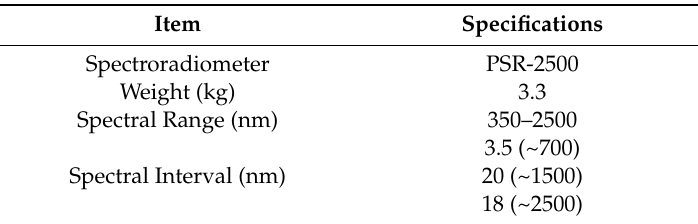
Table 2. Spectroradiometer